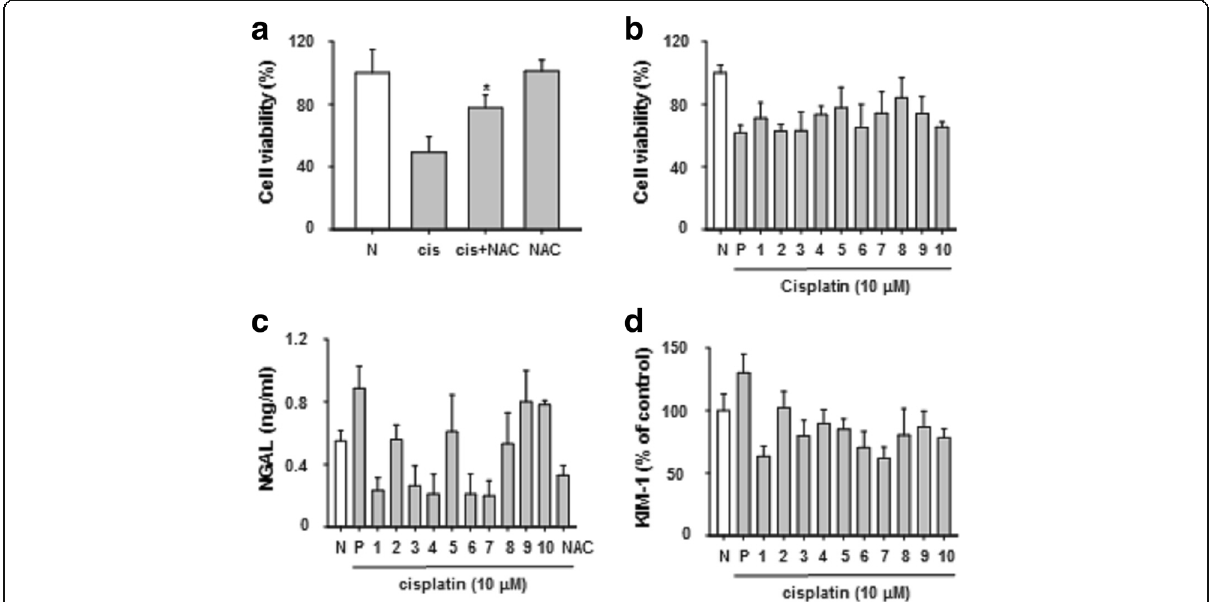
Fig. 2 Herbal medicines regulated NGAL and KIM-1 biomarkers. Pretreatment with NAC 10 mM for 1 h and stimulated with cisplatin (10 μ M) for 24 h ( a ). Cytotoxicity was measured by MTT assay treatment with herbal medicine and cisplatin for 24 h ( b ). NGAL and KIM-1 were measured by ELISA ( c and d ). Lane 1:; Artemisia capillaris , Lane 2:; Houttuynia cordata , Lane 3:; Leonurus japonicas , Lane 4:; Nelumbo nymphaea , Lane 5:; Schisandra chi- nensis , Lane 6:; Akebia quinata , Lane 7:; Ligustrum japonicus , Lane 8:; Paeonia suffruticosa , Lane 9:; Phellodendron amurense , Lane 10:; Trichosanthes kirilo- wii . The statistical significance (* p <0.05) of the observed differences between cisplatin treated and cisplatin + NAC groups were statistically tested by t